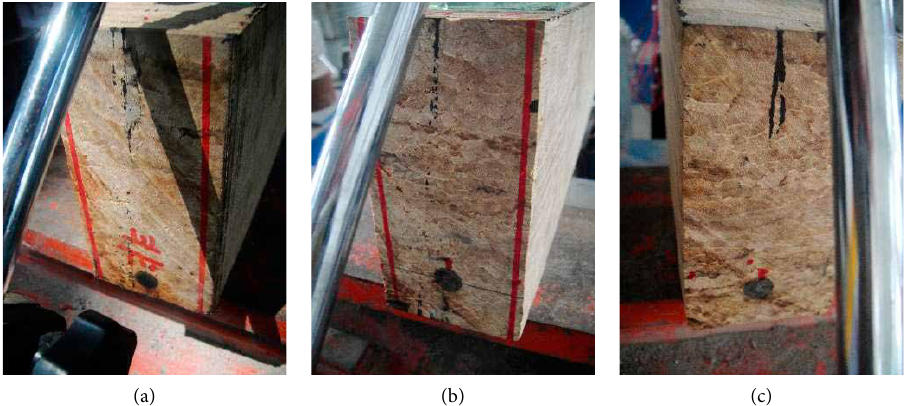
Figure 9: Ends of specimens in the second series after loaded: (a) specimen B0, (b) specimen B1, and (c) specimen